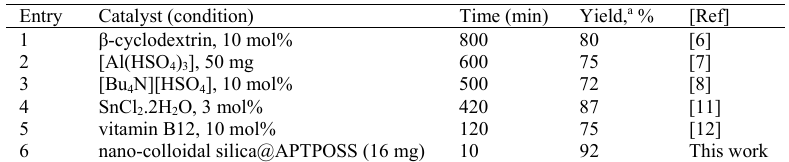
Table 3. Comparison of catalytic activity of nanocatalyst with other reported catalysts for the synthesis of furan-2(5H)-one (4a) Entry Catalyst (condition)